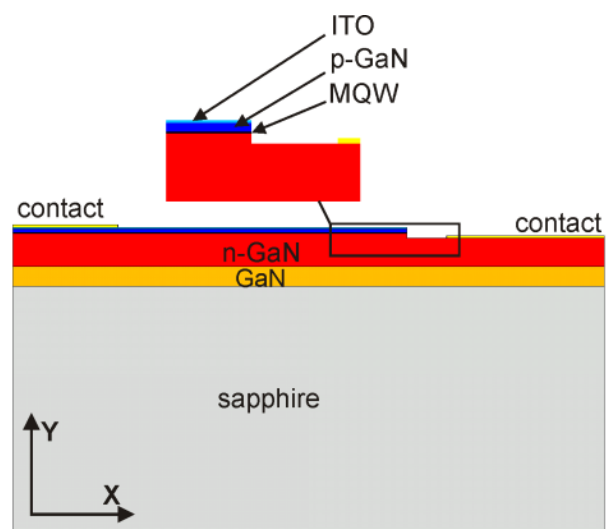
Figure 2. Domain of the model. Table 1. Parameters and dimensions of the modelled preliminary planar GaN LED structure.